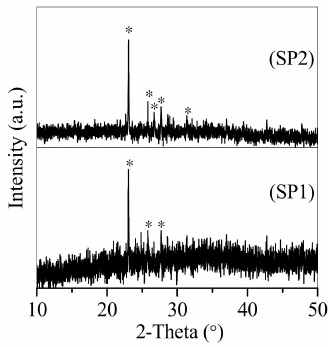
Figure 11. XRD patterns of SP1 and SP2 after electroplating wastewater treatment.